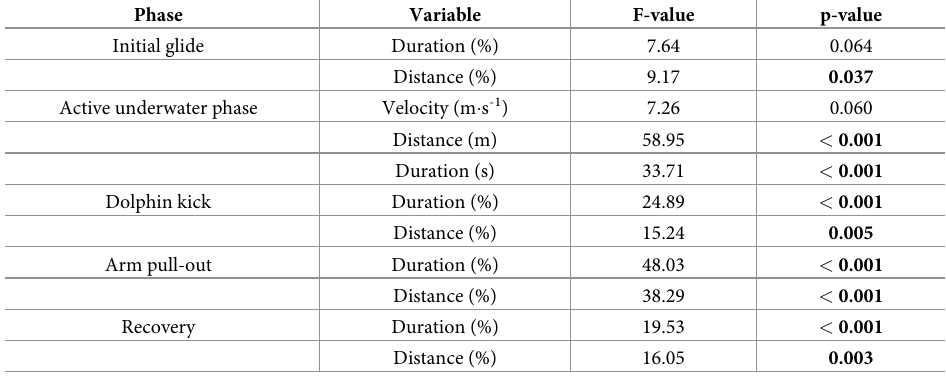
Table 4. Results from the mixed linear modelling assessing the effect of lap on the velocity, distance and duration of the active underwater phase, and the relative duration and distance of each motion.